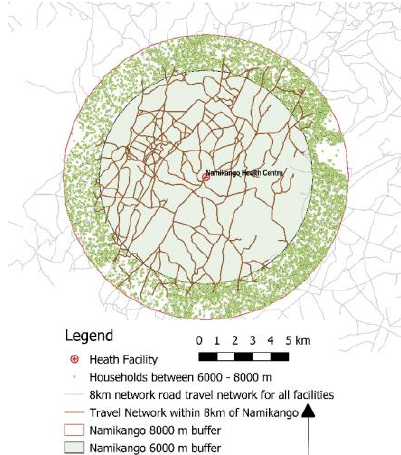
Figure 5 8000 m Travel network for a facility